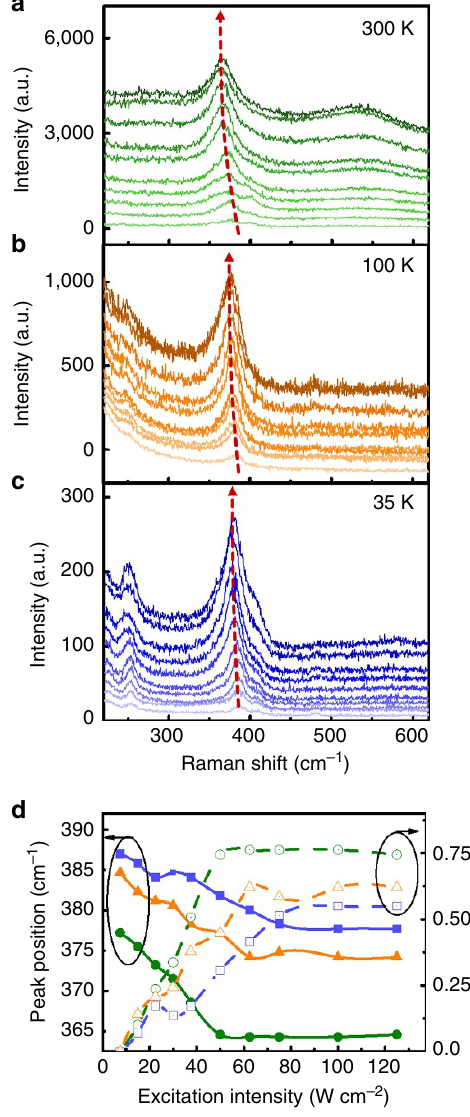
Figure 3 | Dependence of photostriction of SrRuO 3 /SrTiO 3 on temperature and excitation-power intensity. Power-intensity-dependent Raman scattering spectra of SrRuO 3 thin films at ( a ) 300K, ( b ) 100K and ( c ) 35K, respectively. The arrow indicates the redshift of the A g phonon mode induced by the photostrictive effect. ( d ) The Raman frequency of the A g phonon mode (filled symbols) and lattice variation (open symbols) as a function of the power intensity at 300K (circle symbols), 100K (triangle symbols) and 35K (square symbols), Fig. 3a-c. The frequency shift, D o j , and the calculated lattice variation of the SRO thin films are summarized in Fig. 3d. It is notable that the light-induced deformation of SRO decreases at lower temperatures. We hypothesize that above the Curie temperature ( T C,SRO E 144 K), SRO is paramagnetic and essentially has no magnetostriction 23 , which is the effect that occurs when the dimensions of ferromagnetic materials change during the process of magnetization. We believe the light-induced deformation of SRO can be attributed to a phenomenon involving a nonequilibrium of phonons that results from the strong interaction of the lattice and electrons excited by light. Generally, the mechanism of this nonequilibrium of phonons is related to the transfer of energy from light-excited carriers to optical